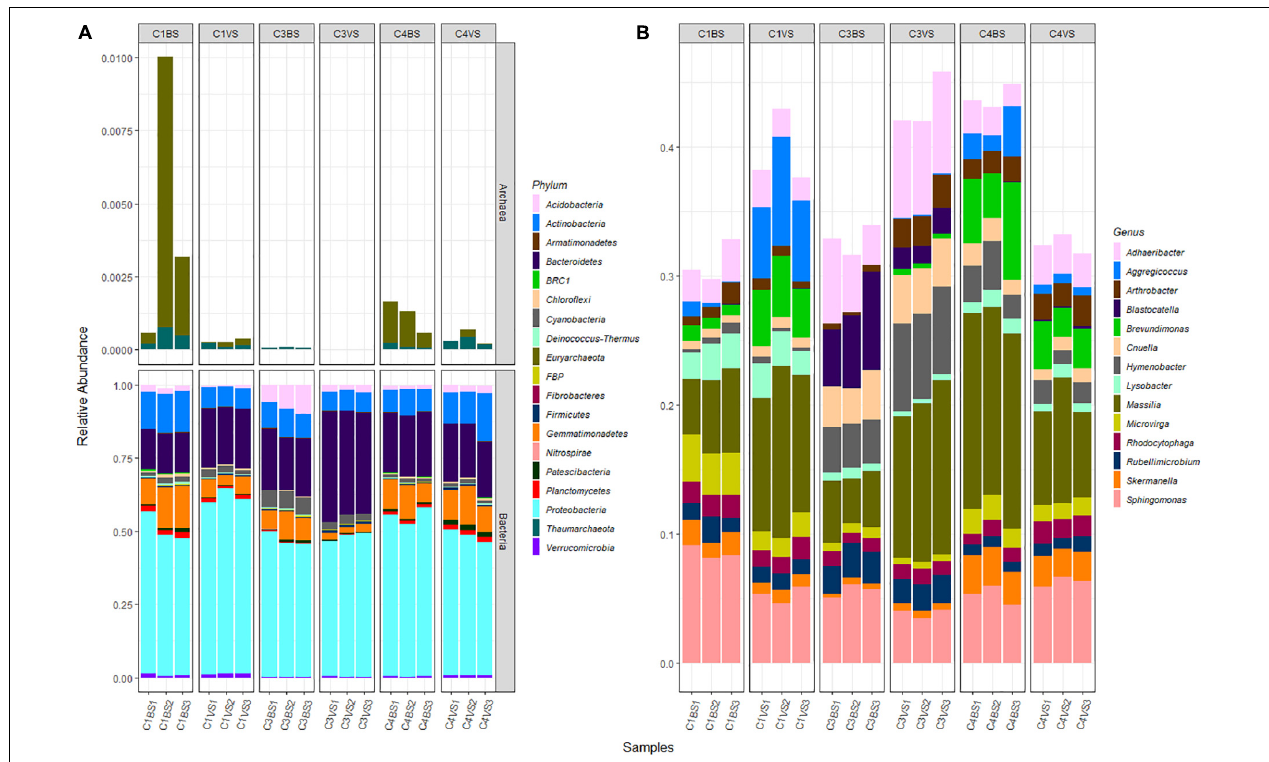
FIGURE 2 | Microbial diversity present in the alkaline phosphate mining wastes. At the phylum level (A) , all sequences are presented, while at the genus level (B) , only the most abundant sequences are presented.